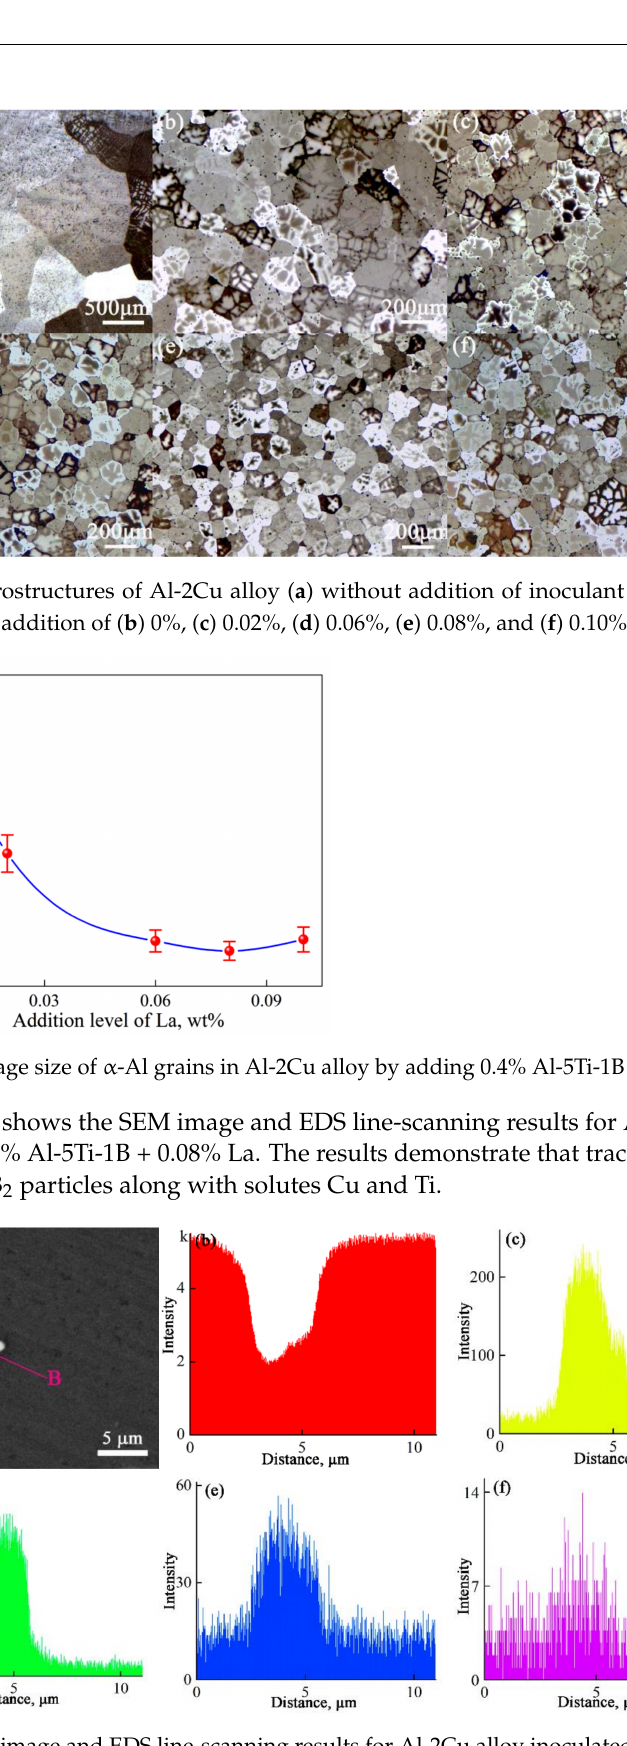
Figure 3. SEM image and EDS line-scanning results for Al-2Cu alloy inoculated with 0.4% Al-5Ti-1B + 0.08% La. ( a ) back-scattered electron image; ( b – f ) distributions of Al, Cu, La, Ti, and B along line A and